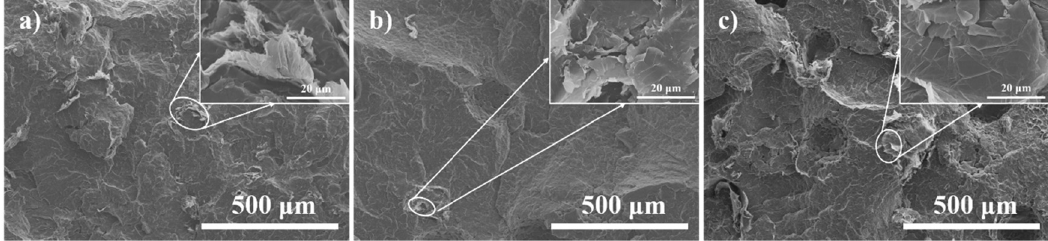
Figure A1: SEM images of T - PP/0.5 ( a ) , T - PP/1.0 ( b ) , T - PP/3.5 ( c ) . It can be observed that large - scale GNPs are stacked together, and there are some holes in the cross - section, which indicates that the GNP dispersion e ff ect is poor, and a satisfactory dispersion e ff ect cannot be obtained through two - screw compounding. Compared with Figure 1, this further illustrates the necessity and superiority of solid - state shear